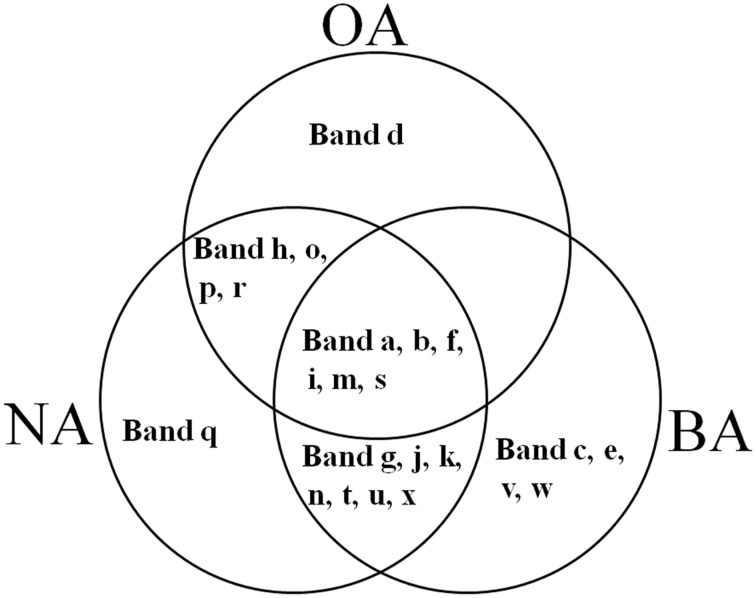
Venn diagram showing the shared and unique bands detected in the CYP153 gene DGGE profile of activated sludge. OA, represents the original activated sludge; NA, represents the activated sludge from the non-trehalose BA reactor; BA, represents the activated sludge from the trehalose BA reactor.